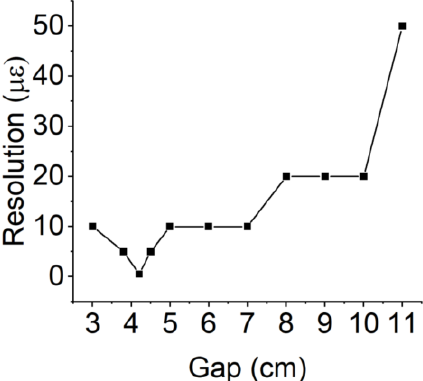
Figure A6. The resolution of the passive wireless sensor.